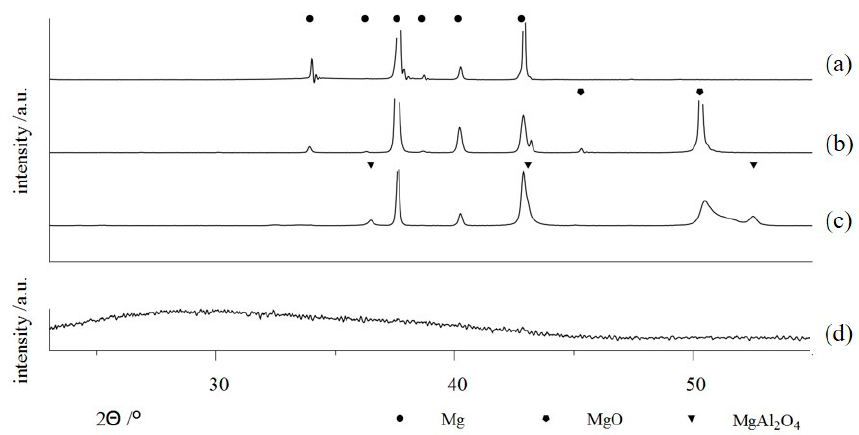
Figure 6. X-ray Diffraction (XRD)-diffractograms on bare AZ31 substrate, (a) and PEO coatings on AZ31 generated within several alkaline electrolytes; a low concentration phosphate solution, designed for substrate conversion, (b) high concentration silicate and aluminate electrolytes, designed for focused incorporation of electrolyte constituents (c,d) [20,21]. (Apapted from [20,21])